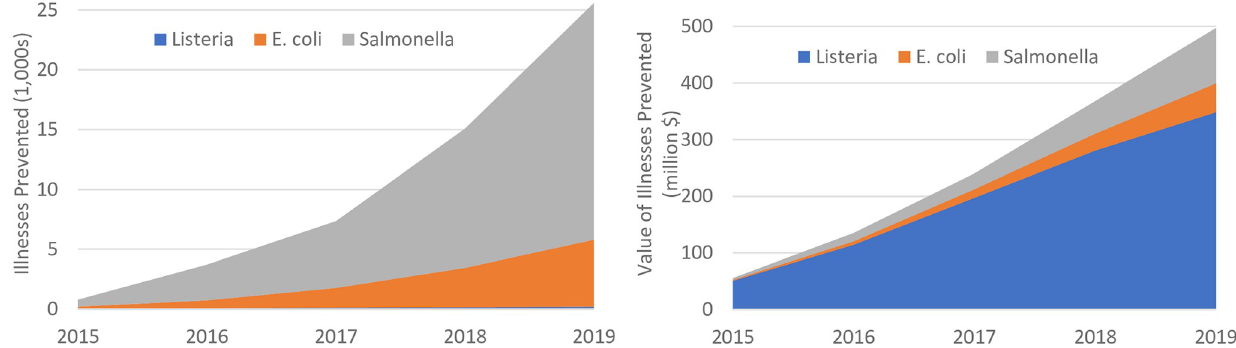
Fig 2. Estimated illnesses prevented per pathogen. Annual illnesses and associated monetary burden estimated to be prevented for Listeria , E . coli ., and Salmonella ; a graphical illustration of Table 4.